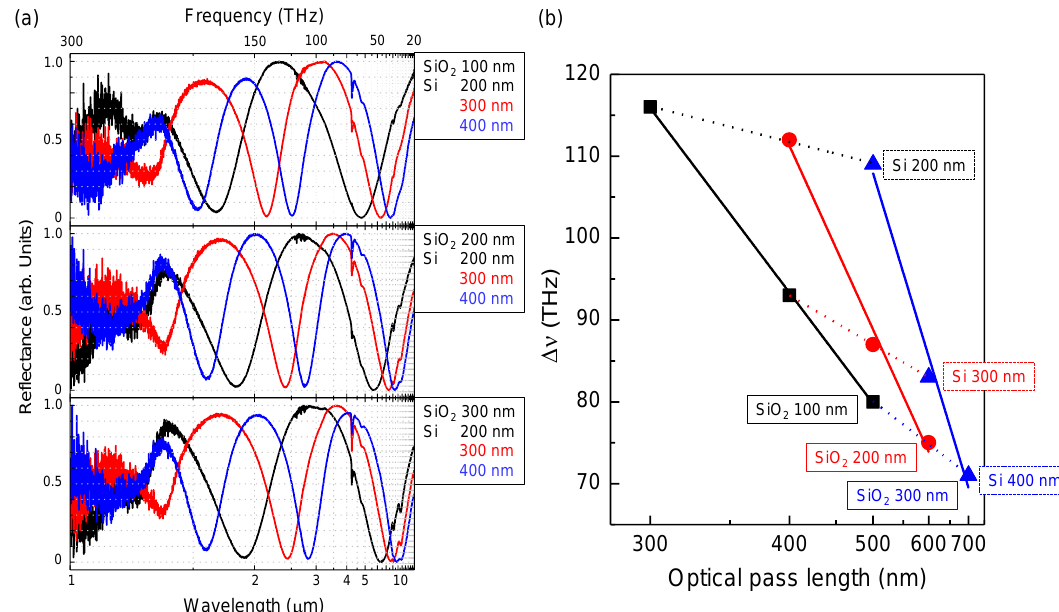
Figure 3. ( a ) Reflection spectra of the fabricated black metal samples with SiO 2 layer thickness changing from 100 to 300 nm and Si from 200 to 400 nm. ( b ) The full width at half maximum (FWHM) ∆ ν vs. optical path length, calculated as combined thickness of Si and SiO 2 layers at normal incidence. The slope of the dependence defines the group index n g